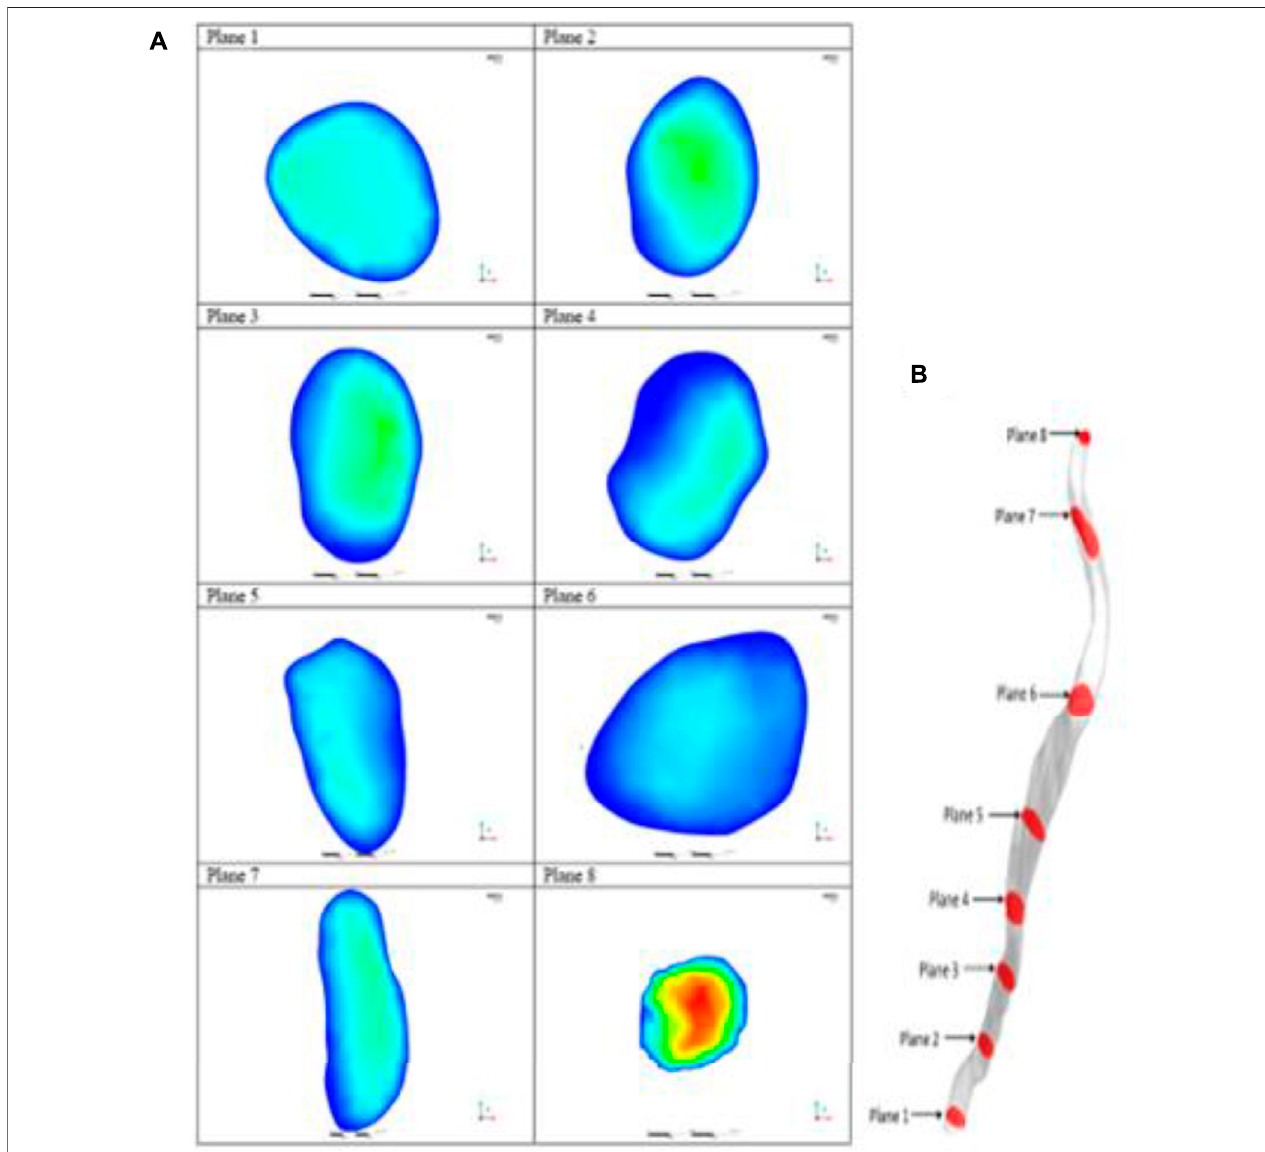
FIGURE 11 | (A) Velocity contours at planes of interest. (B) Planes positioned at the “ areas of interest ” in the patient-speci fi c model.